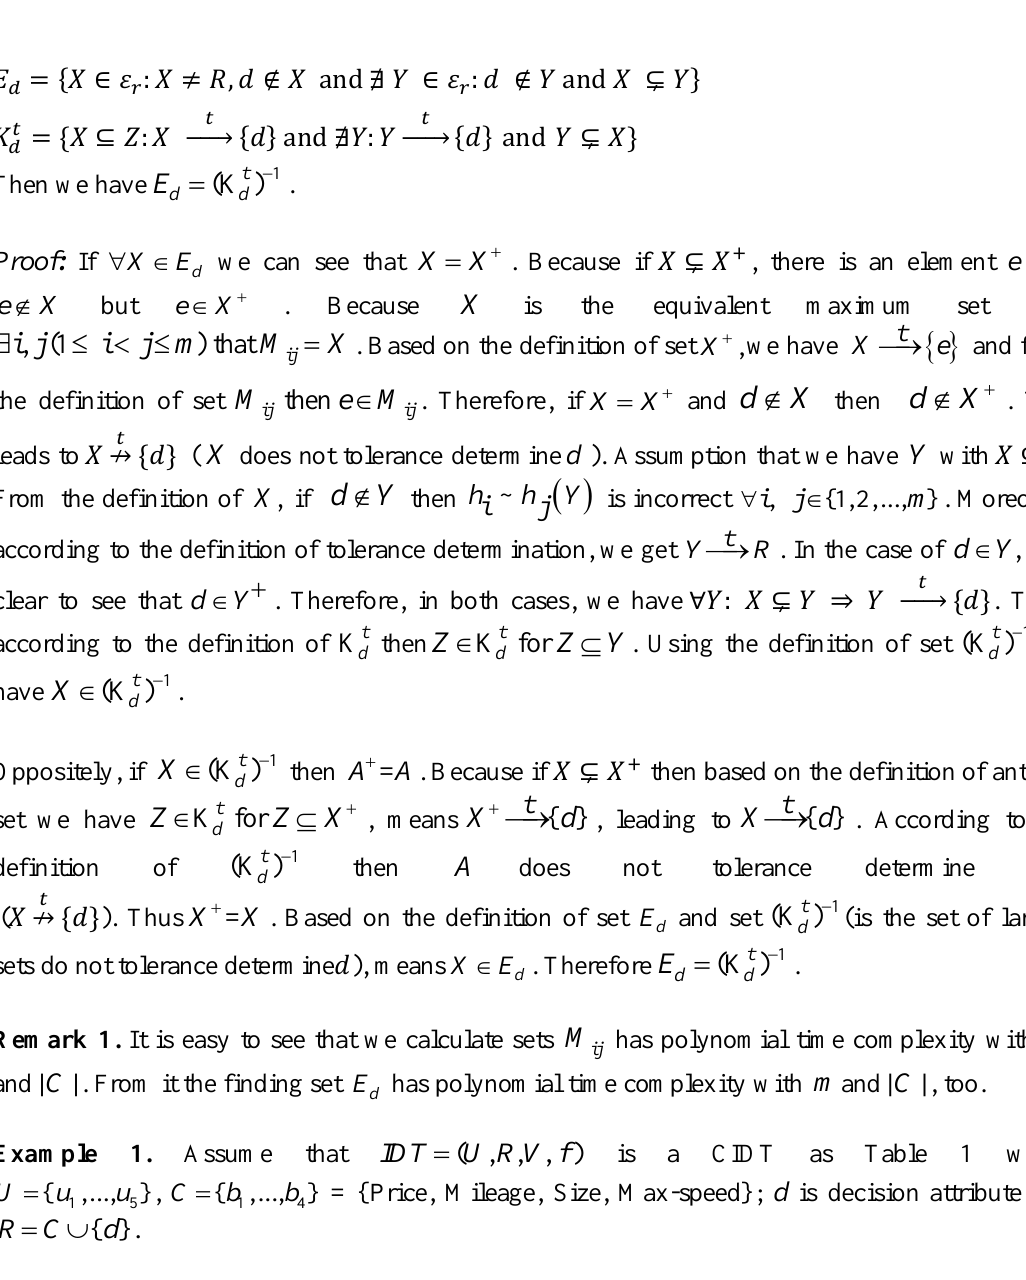
Table 1. An incomplete decision table of car